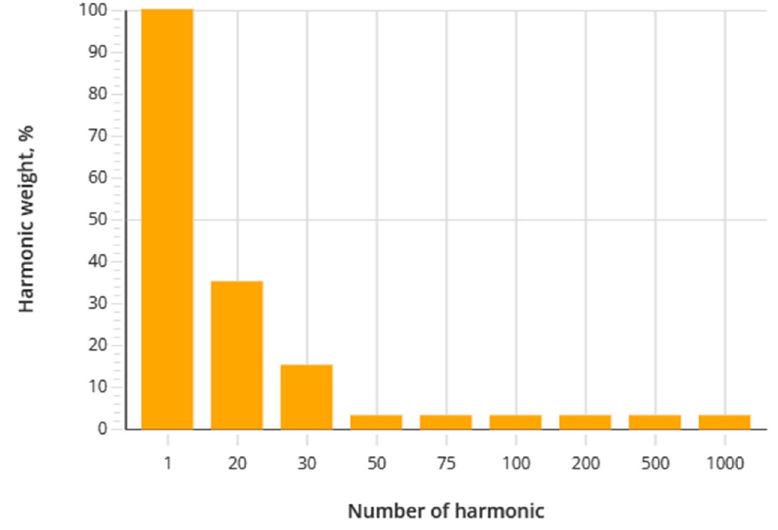
Figure 6. Data harmonic weight dependence on its number.